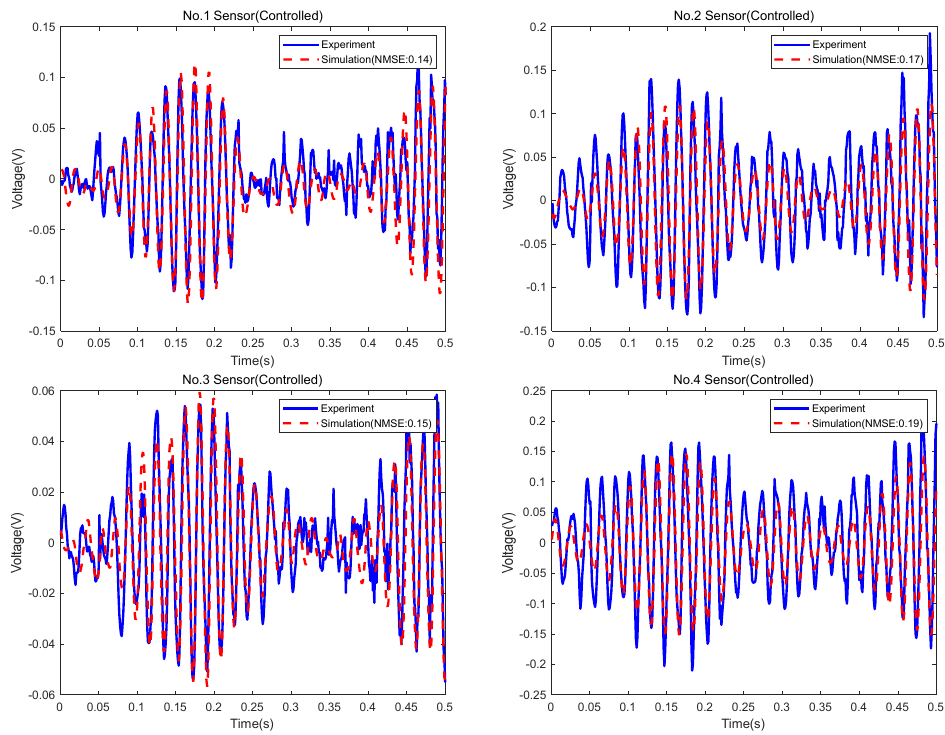
Figure 20. Comparison of sensor signals in time domain. Comparison of Experiment #1 and Simulation #1.